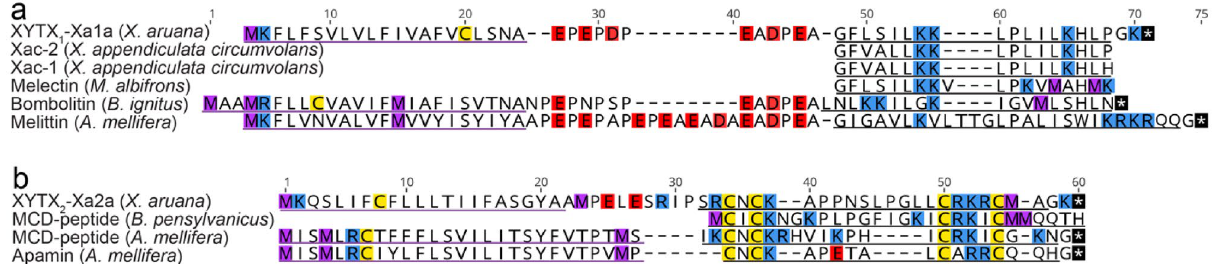
Figure 2. Amino acid sequence alignments of the peptide toxins of X. aruana venom with homologues from other Apidae venoms. ( a ) XYTX 1 -Xa1a alignment with Xac-1 (Uniprot: C0HKQ5), Xac-2 (Uniprot: C0HKQ6), melectin (Uniprot: P86170), bombolitin (Uniprot: D0VDZ4) and melittin (Uniprot: P01501). ( b ) XYTX 2 -Xa2a alignment with apamin (Uniprot: P01500), Bombus MCD-peptide (Uniprot: P04567) and Apis MCD-peptide (Uniprot: P01499). Methionine, lysine/arginine, aspartate/glutamate, and cysteine residues and stop codons are highlighted in purple, blue, red, yellow and black, respectively. Signal peptides and mature peptides are underlined in purple and grey, respectively. Post-translational modifications are not